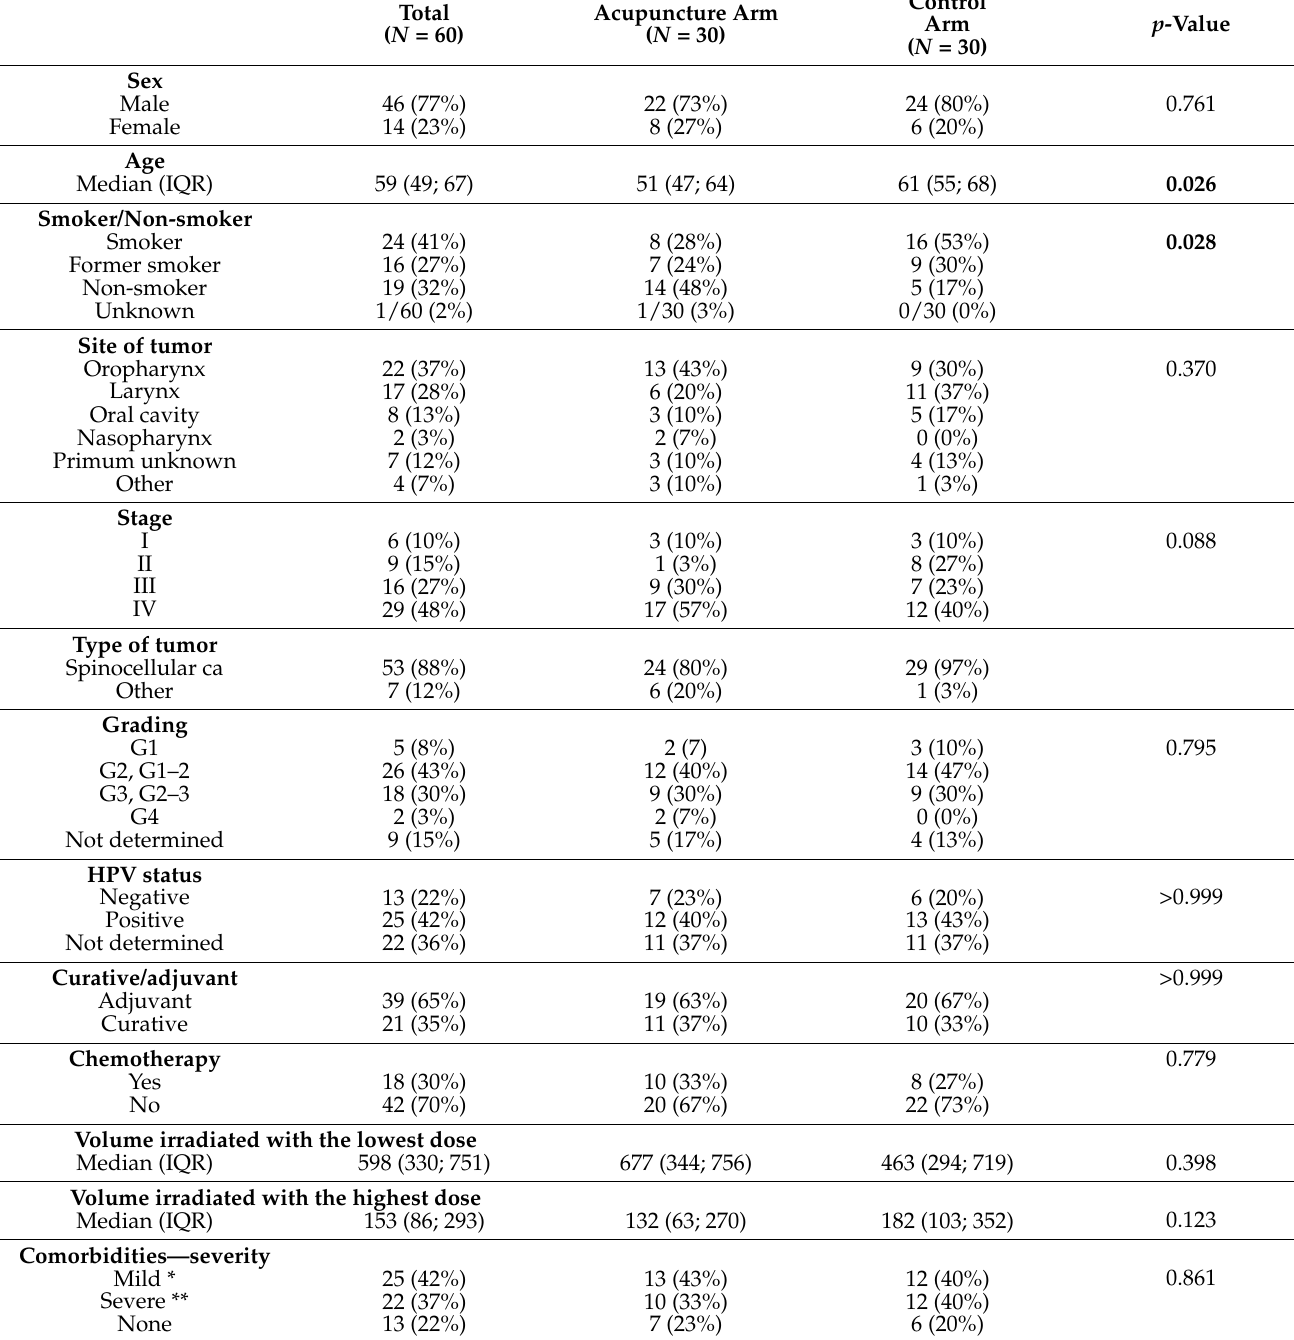
Table 1. Demographic and treatment